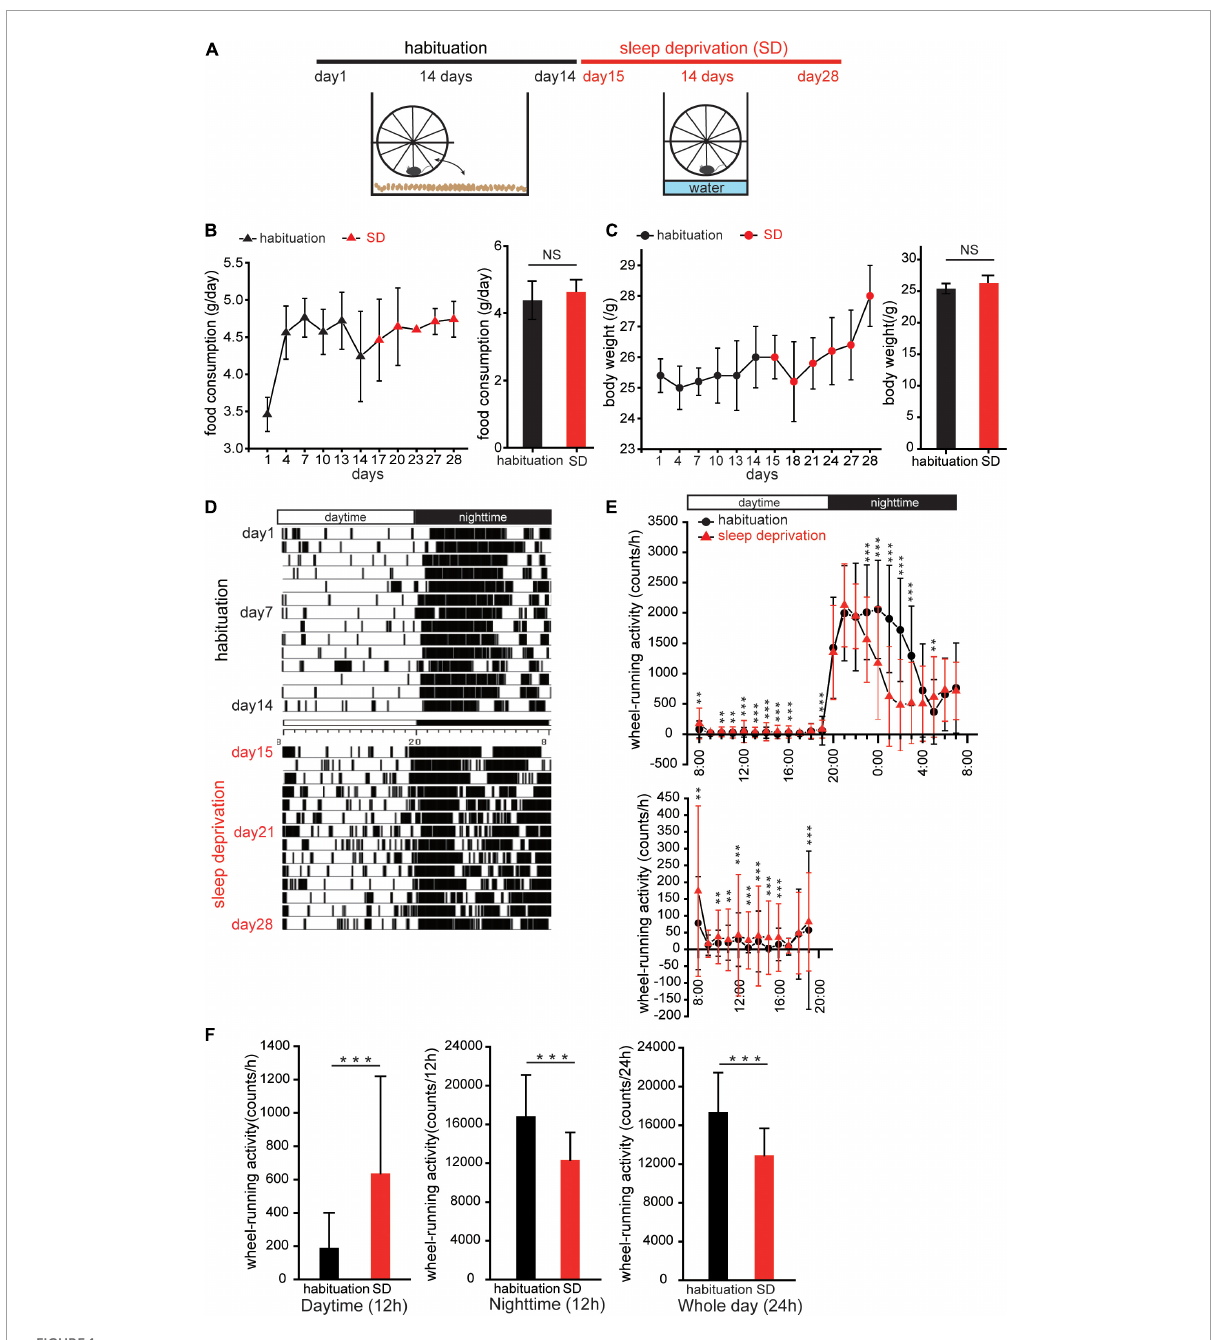
FIGURE1 Sleep deprivation disturbs circadian activity. (A) Protocol for creating mice with disturbed circadian activity. Mice were kept in cages with running-wheels, which they could move freely onto and off in the first 2 weeks (habituation). In the third week, the bedding in each cage was replaced with water to a depth of 1.5 cm. Thereafter, the mice remained on the running-wheel throughout the day to avoid contact with the water (sleep deprivation, SD). (B,C) Food consumption and body weights during habituation and SD. Triangles (black, habituation; red, SD) represent changes in food consumption over 28 days; circles (black, habituation; red, SD) represent changes in body weights. No significant differences in food consumption and body weights between habituation and SD periods were observed ( n = 5 mice; food consumption, p = 0.13; body weight, p = 0.06; Mann–Whitney U test). (D) Representative actogram of wheel-running events during habituation and SD periods. (E) Wheel-running activity during habituation (red, triangle) and SD (black, circle) periods plotted over 24 h. Wheel activity in 1 h bins was averaged for 14 days during habituation and SD periods, and the values from individual mice were averaged to yield a single 24 h profile ( n = 5 mice). The lower figure shows wheel-running events during the daytime at different scales. * p < 0.05, ** p < 0.01, and *** p < 0.001. (F) Comparison of wheel-running activity between habituation and SD periods during the daytime (left), night-time (middle), and whole day (right), respectively ( n = 5 mice, *** p < 0.001; Mann–Whitney U